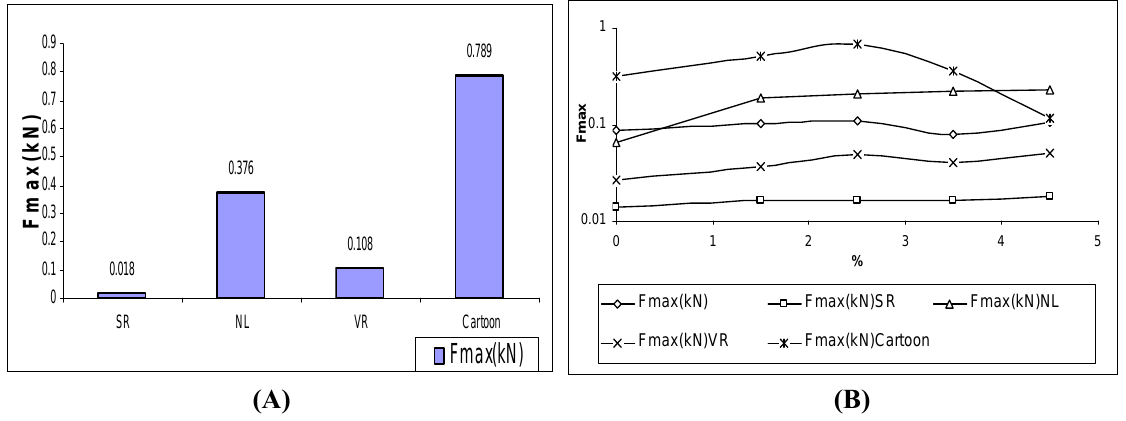
Fig. 13 : (A)Fmax of adherent materials. (B)Fmax of PVA before and after SiO different